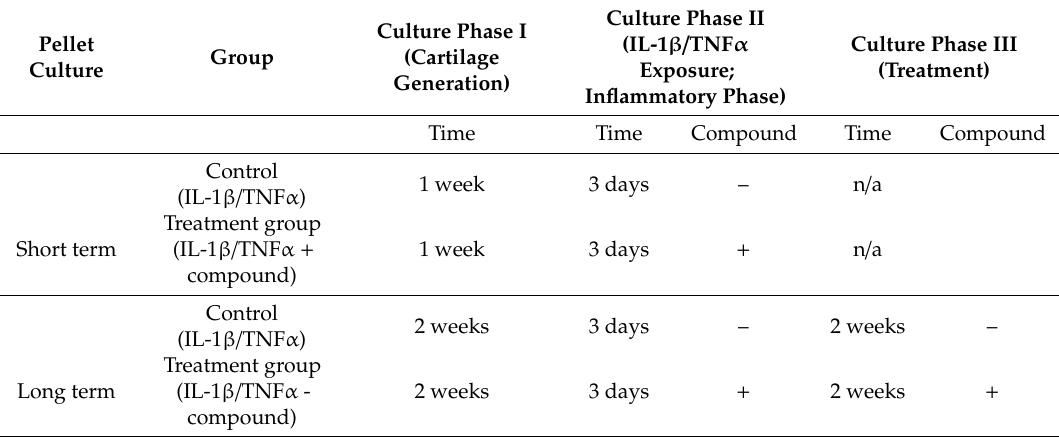
Table 3. Description of experimental